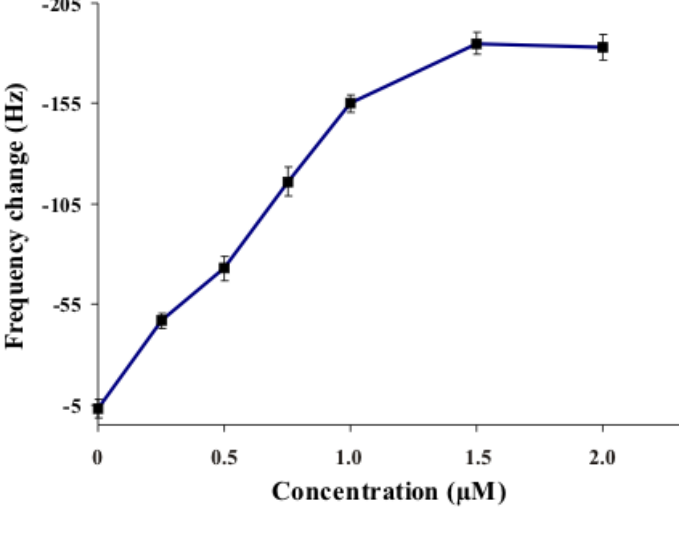
Figure 2. Resonant frequency change of quartz crystal by thiol-modified oligonucleotide probe for synthetic DNA target hybridization. The resonance frequency was measured and calculated for the frequency change. The frequency changes were represented by the frequency differences between this final value (F2) and the DNA probe immobilization (F1) as the baseline before the hybridization reaction ( ∆ F = F1-F2). Each data point represents the mean ± SD (n =